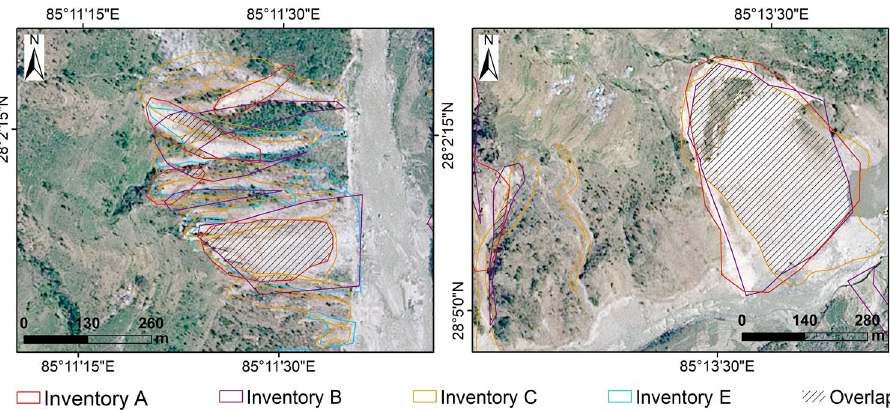
Figure 4. Landslides mapped (examples in two figures) by different authors after the Gorkha Earthquake. The satellite image is SPOT-7, taken on May 03, 2015, provided by AIRBUS DS. Inventory ( A – C ) are available